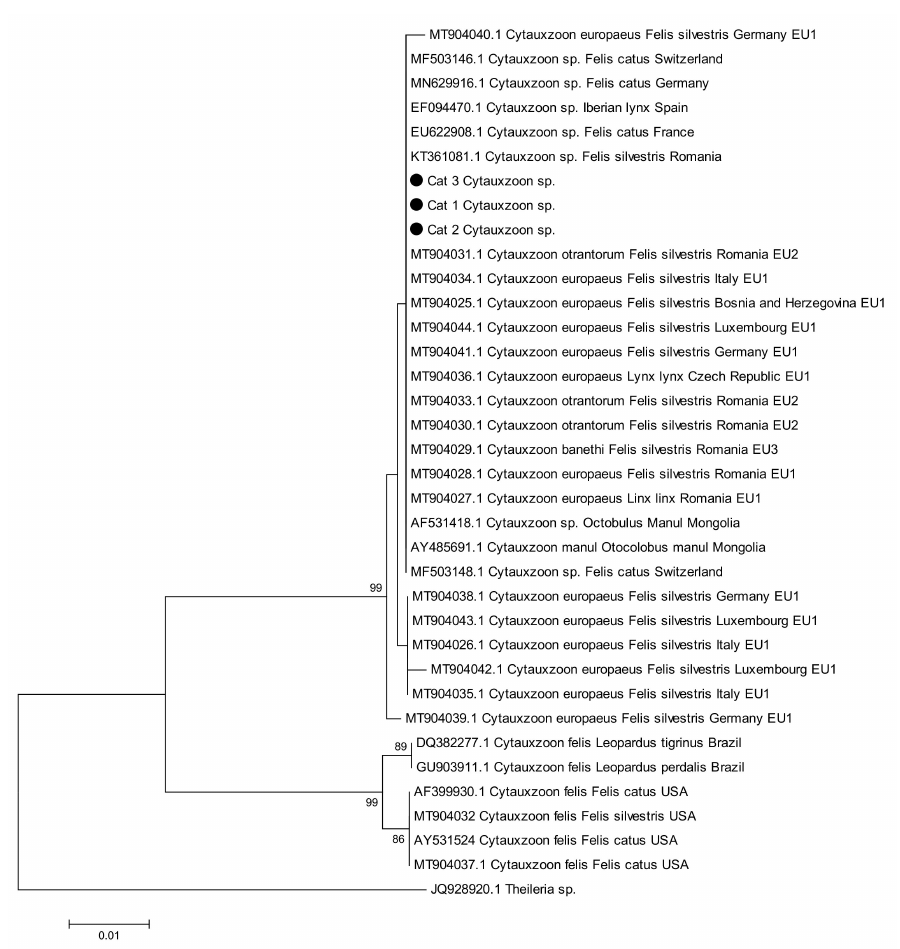
Figure 2. Phylogenetic tree based on 18S rDNA gene partial sequences (~445 bp) of Cytauxzoon spp. (all Cytauxzoon species). The sequence dataset was analyzed using MEGA v6.0. The tree was constructed using the neighbor-joining (NJ) method and bootstrap analysis (1000 replicates) based on the ClustalW algorithm. Significant bootstrapping values (>70%) are shown on the nodes. Theileria spp. was used as outgroup. The sequences of this study, accession numbers OM281707–OM281709, are indicated by black dot ( •